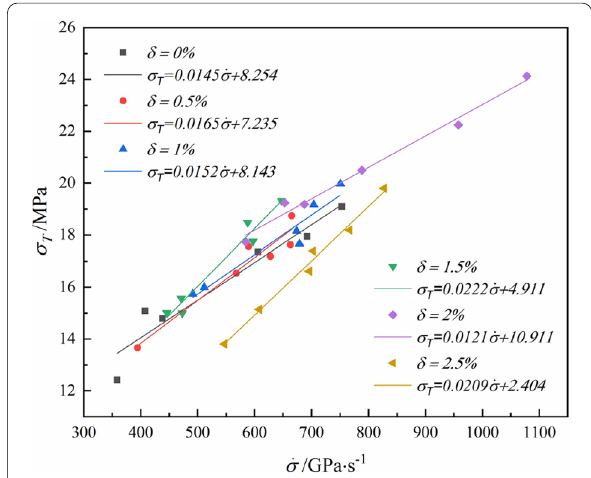
Fig. 6 Variation of tensile strength under different loading